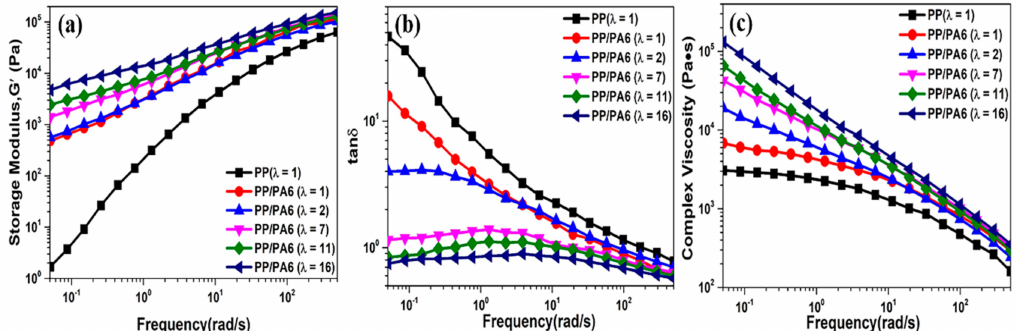
Figure 8. Shear rheological behavior of the pure PP and the PP / PA6 blends with di ff erent stretch ratios at 200 ◦ C. ( a – c ) The dependencies of storage modulus, loss tangent and complex viscosity on the frequencies, respectively.